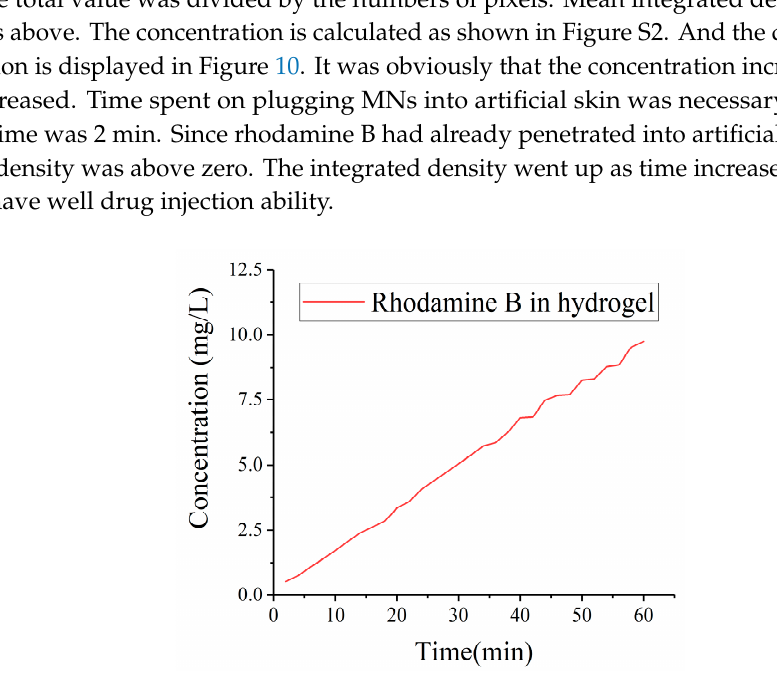
Figure 10. Integrated Density of rhodamine B in artificial skin.